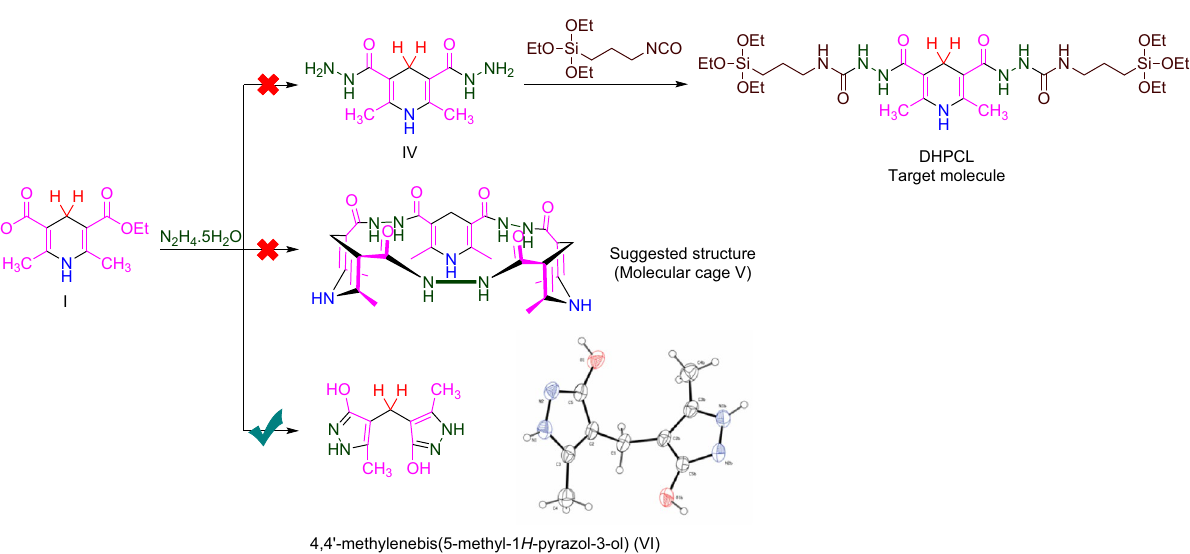
Scheme 8. Reaction of the I and hydrazine hydrate leads to formation of VI